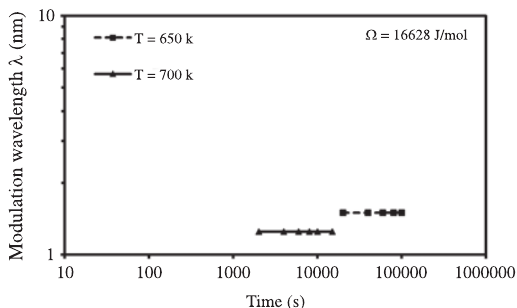
Figure 13. Plots of modulation wavelength λ vs. time t for